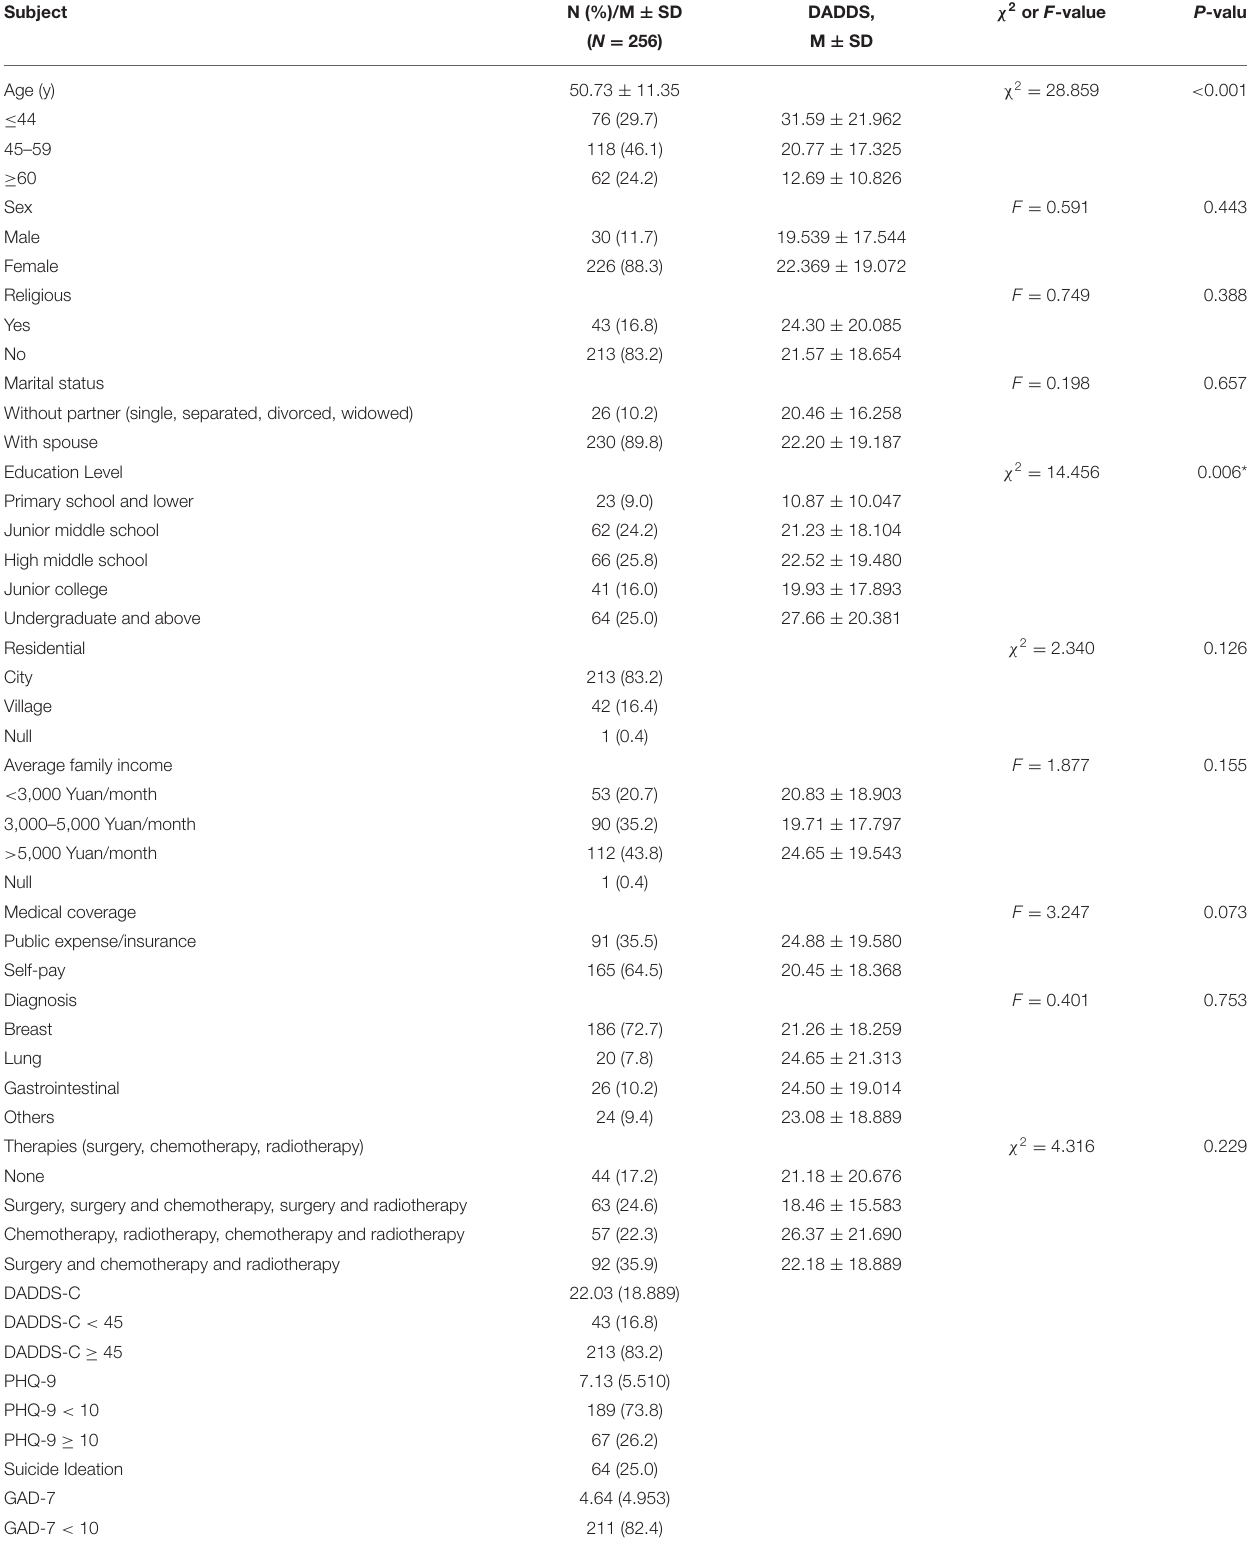
TABLE 1 | Social demographic and medical information, discrepancy of DADDS among different